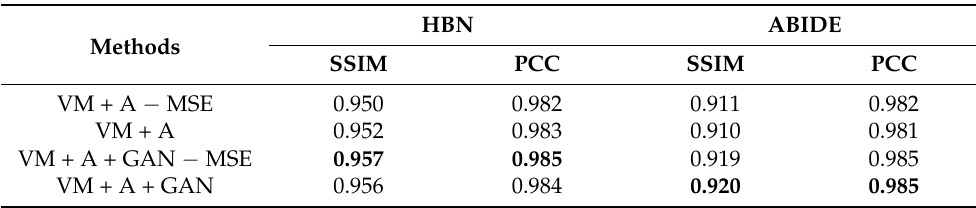
Table 6. SSIM and PCC values when using the MSE loss function and the HBN and ABIDE datasets. Bold numbers indicate the best results.